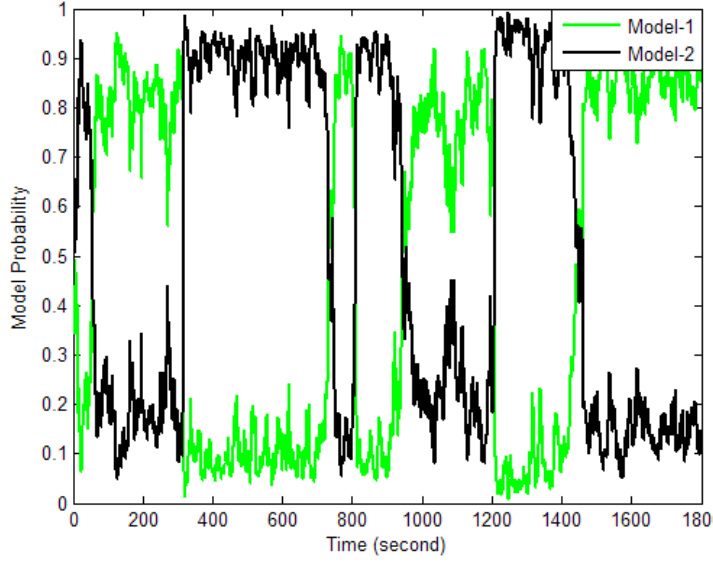
Figure 14. Model probability of